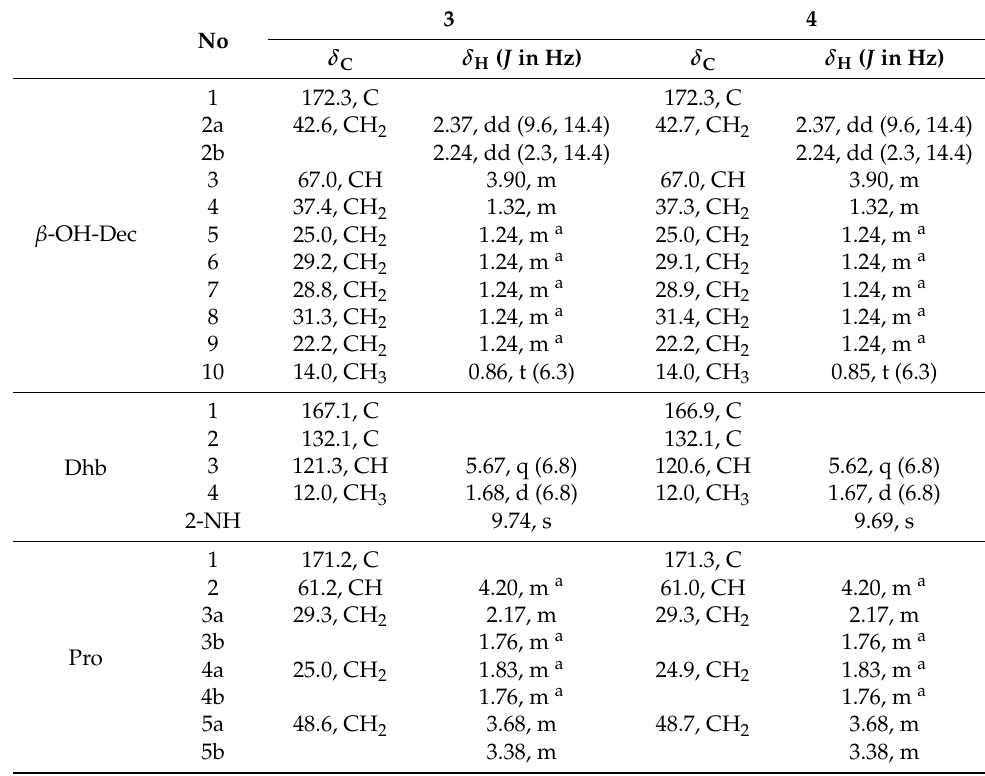
Figure 4. Key ( 1 H– 1 H correlation spectroscopy) COSY, (Heteronuclear multiple bond coherence spectroscopy) HMBC, and (Nuclear overhauser effect spectroscopy) NOESY correlations of compounds 1 – 10 . Table 2. The 1 H (500 MHz) and 13 C NMR (125 MHz) data of 3 – 4 in DMSO- d